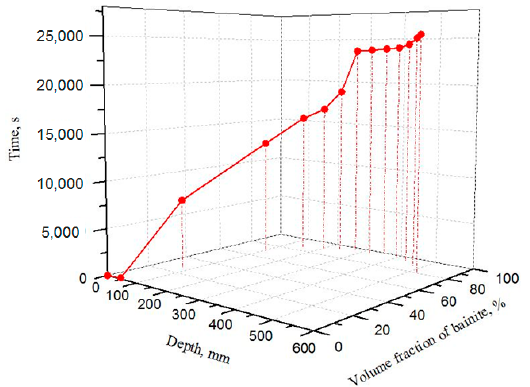
Figure 12. Calculated bainite distribution of condition (D).